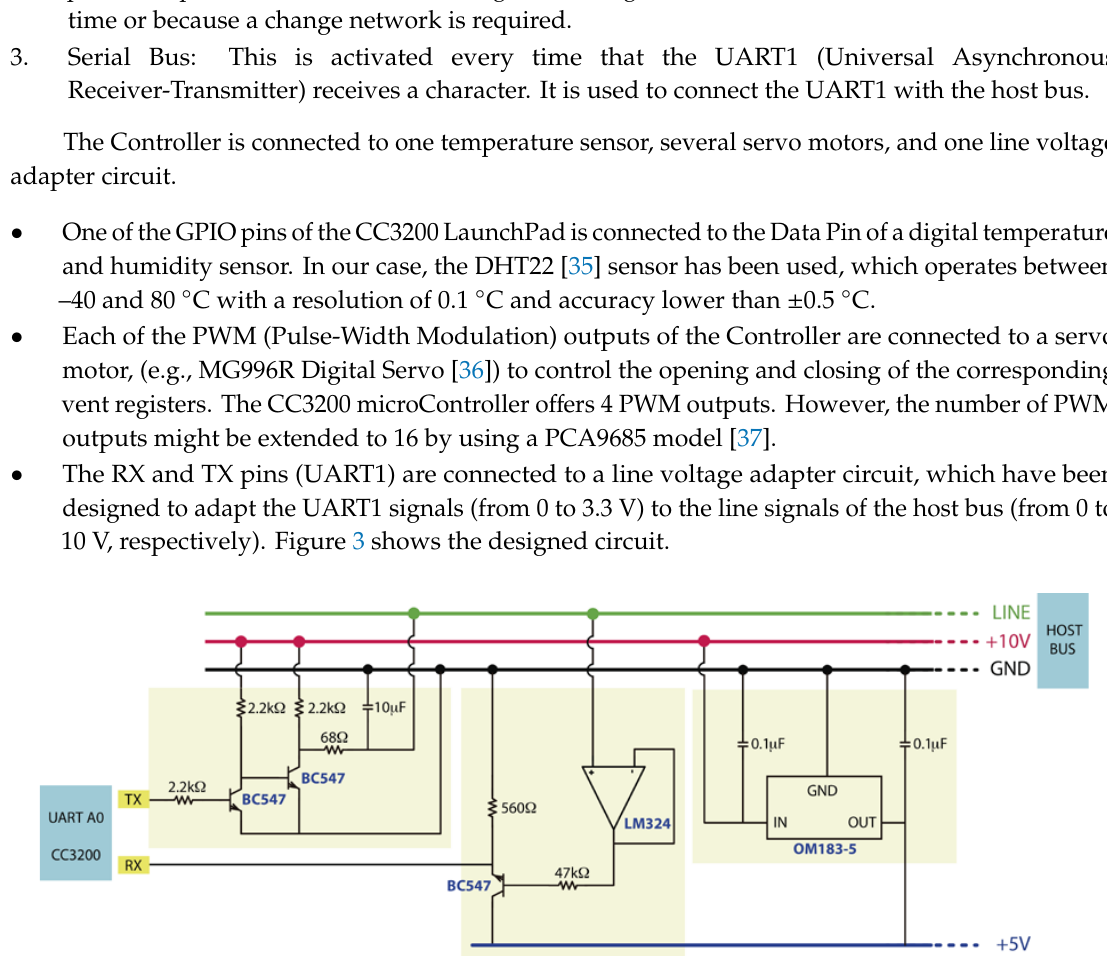
Figure 3. Line voltage adapter circuit.